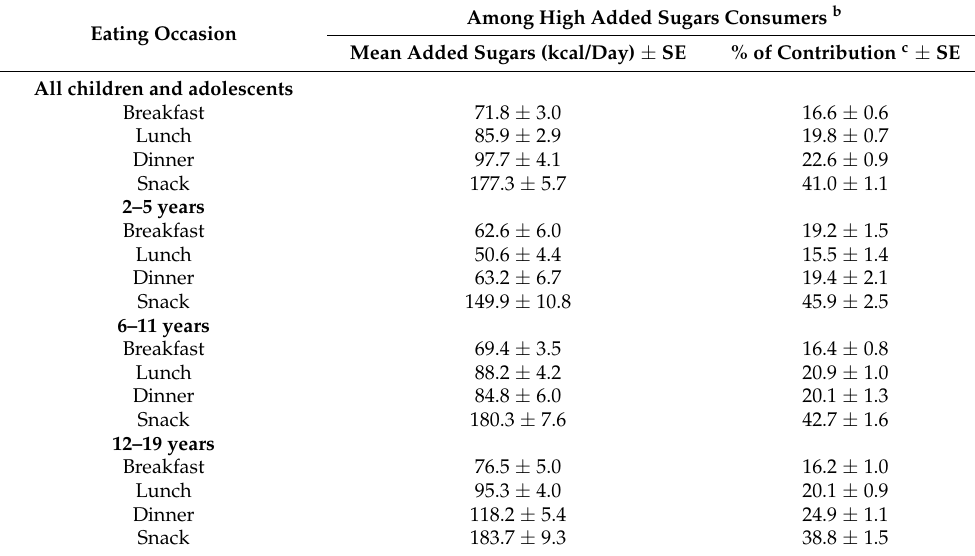
Table 2. Added sugars consumption by age and eating occasions among high consumers